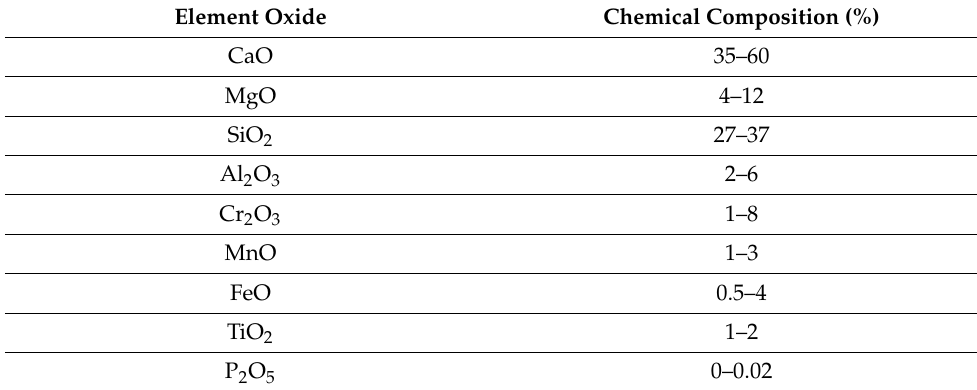
Table 1. Chemical composition of slag.